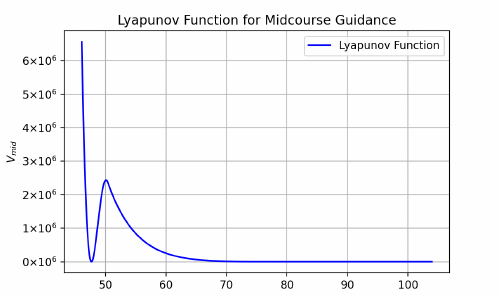
Figure 16. Lypunov functions of midcourse guidance.